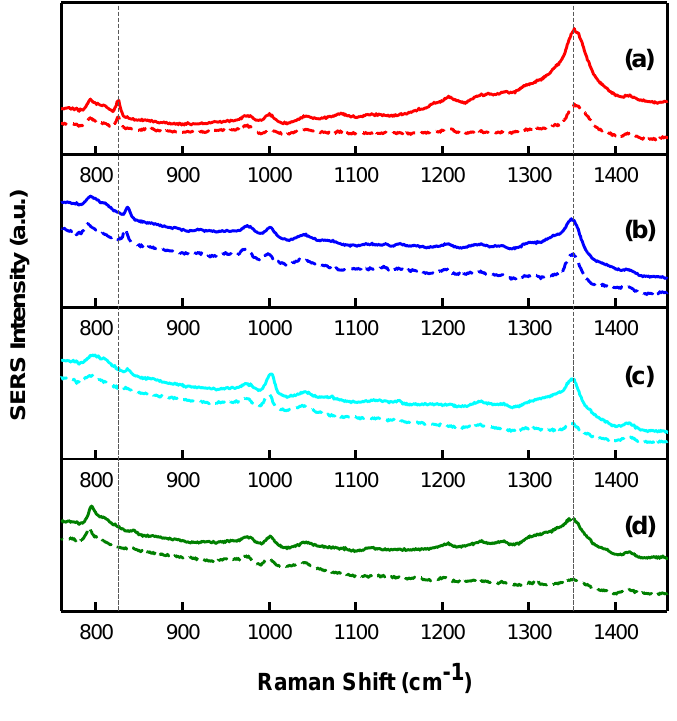
Figure 9. SERS spectra recorded for a MIP after incubation in a 7.5 × 10 −5 M solution of (a) TNT, (b) 2,4-DNT, (c) 1,3-DNB, and (d) 2,6-DNT. The vertical dashed lines are aligned with the characteristic NO out-of-plane bending and stretching modes of TNT. 2 Spectra are offset for